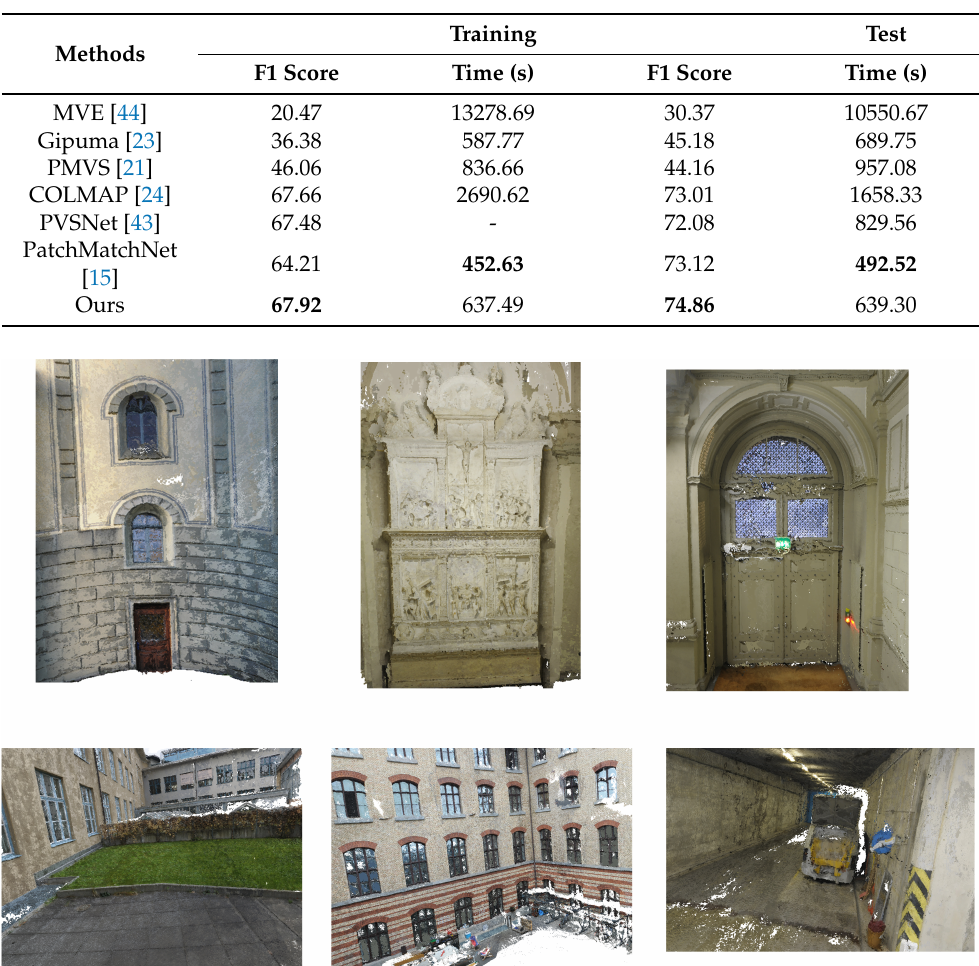
Table 3. Quantitative results of different methods on ETH3D [11] (F score, higher is better). Due to the high variability of viewpoints, the only competitive purely learning-based approach currently